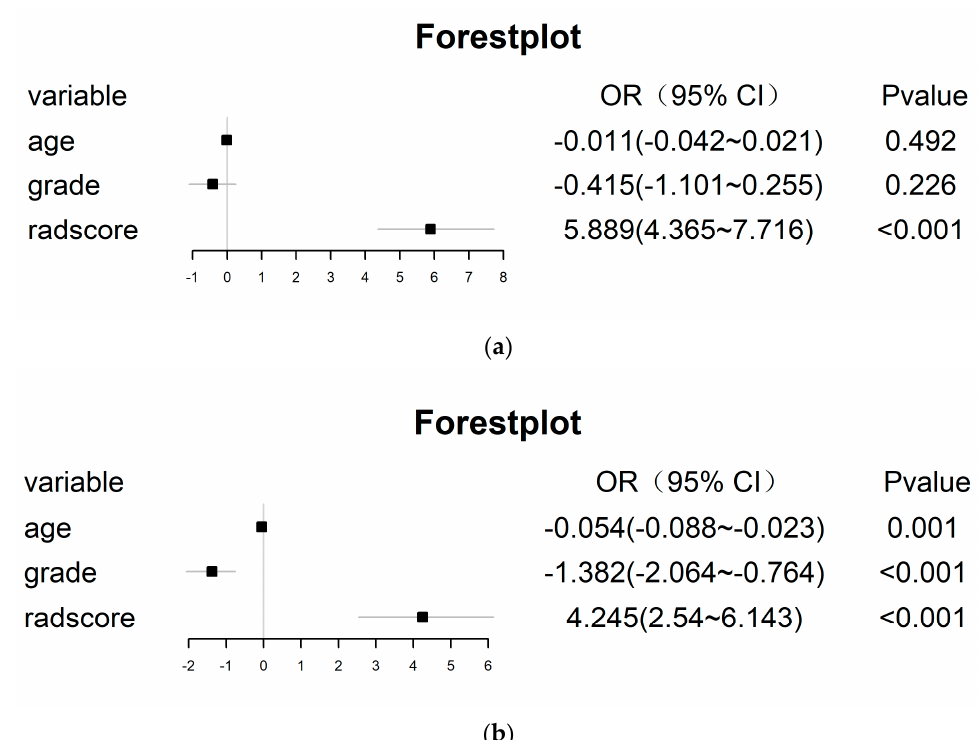
Figure 8. ROC curves of the clinical model in the un-SMOTE training cohort, test cohort and independent TCGA/TCIA validation cohort.